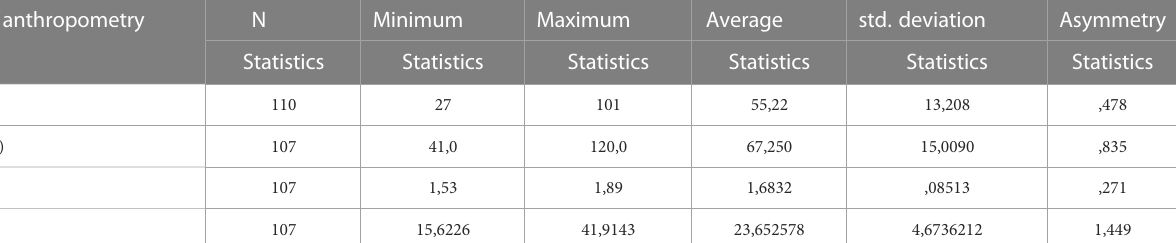
TABLE 1 Average age and anthropometry. Age and